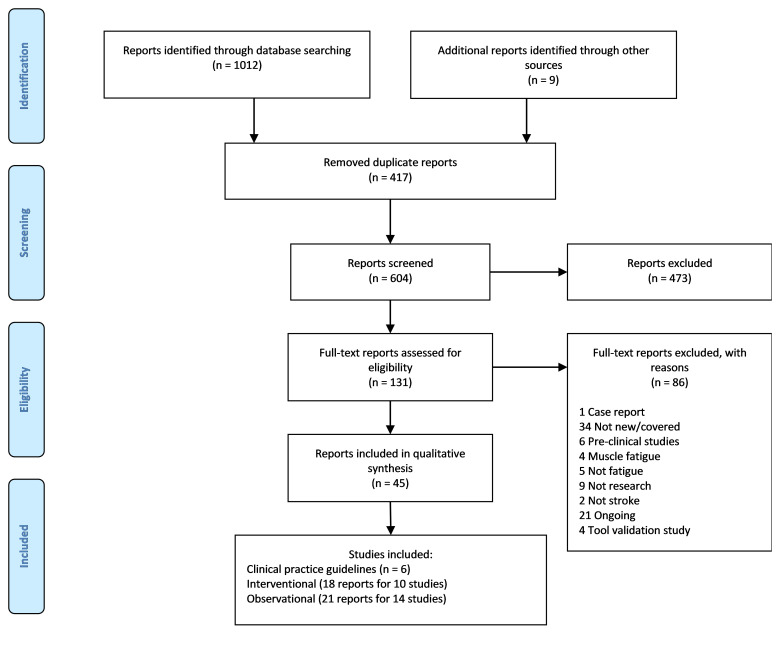
PRISMA flow diagram.